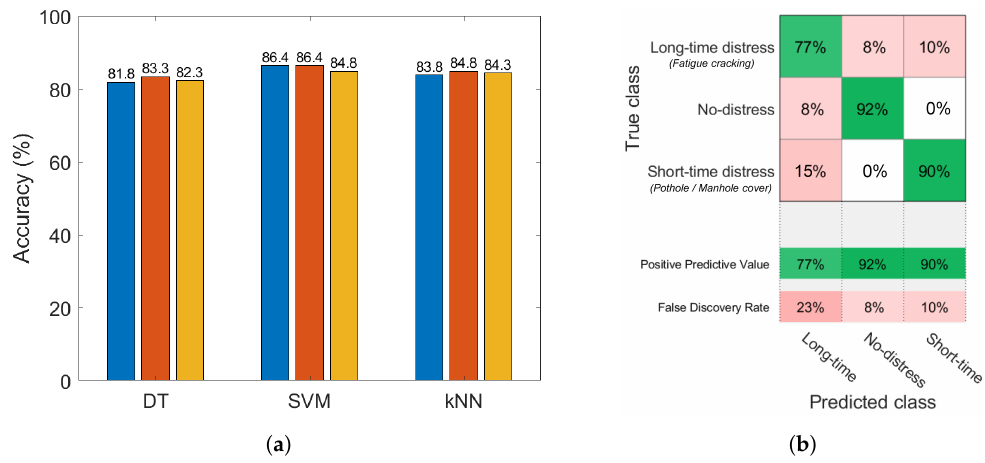
Figure 8. Classification results obtained by merging the data collected on both the car’s dashboard and the car’s floorboard; predictive accuracy of the considered supervised learning classification families: DT (2, 5, 10 splits), SVM (linear, quadratic, cubic kernels), k NN (1, 10, 30 neighbours) ( a ); confusion matrix of the linear SVM classifier ( b